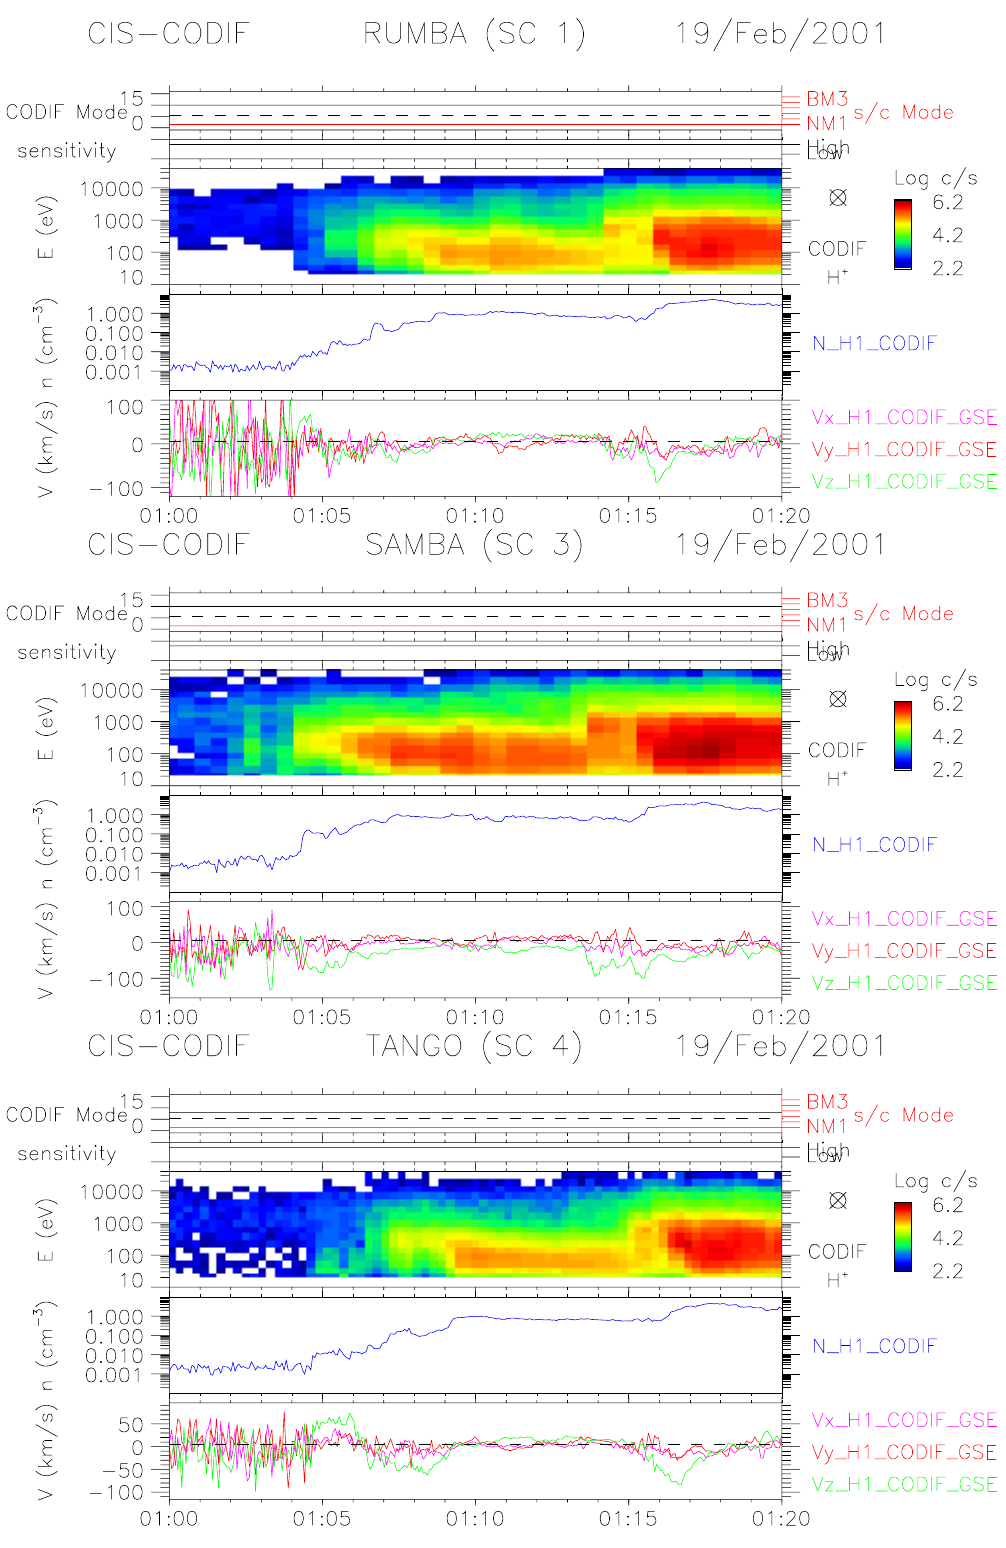
Fig. 35. CODIF measurements on board spacecraft 1, 3 and 4, on 19 February 2001, between 01:00 and 01:20UT. See Fig. 34 caption for the details of the